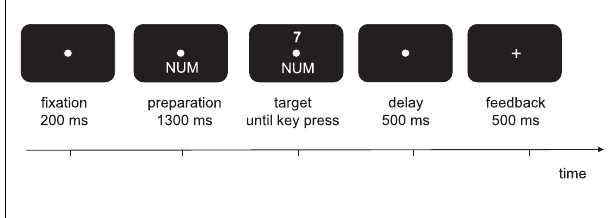
FIGURE 1 | Schematic illustration of a